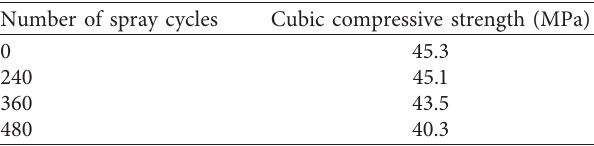
Table 2: Mechanical properties of the concrete